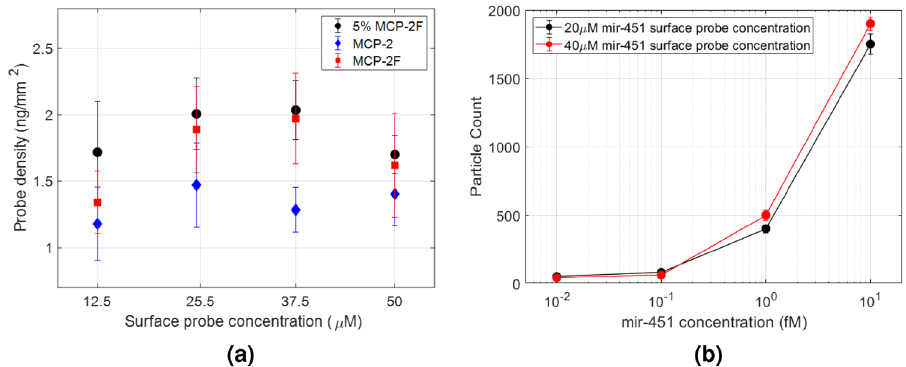
Figure 3. Comparison of immobilized surface density with respect to three different polymers at different probe spotting concentrations ( a ). Effect of probe spotting concentration in particle capture efficiency ( b